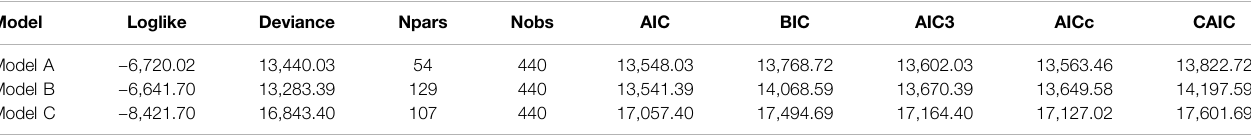
TABLE 2 | Information criteria for the estimated models. Model A represents a one-dimensional model. In model B, four items were assigned to a second dimension, and in model C, single-item categories were attributed to a second dimension. Model